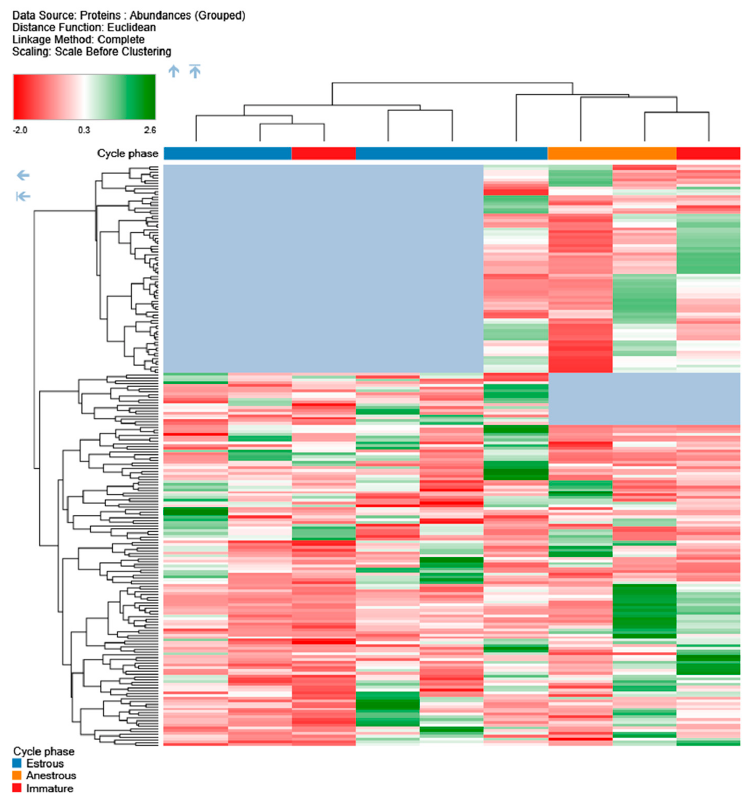
Figure 2. Hierarchical clustering of urine samples. Samples collected during estrus phase are indicated in orange color, and samples from anestrus phase are indicated in blue color, while samples from immature animals are in red.